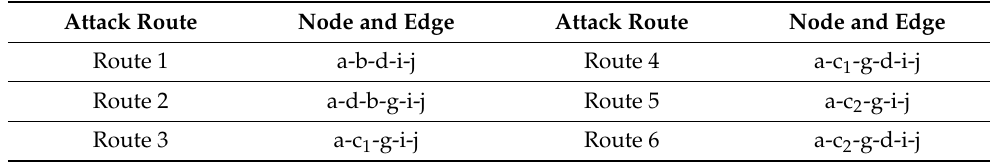
Table 8. Nodes and edges along the attack